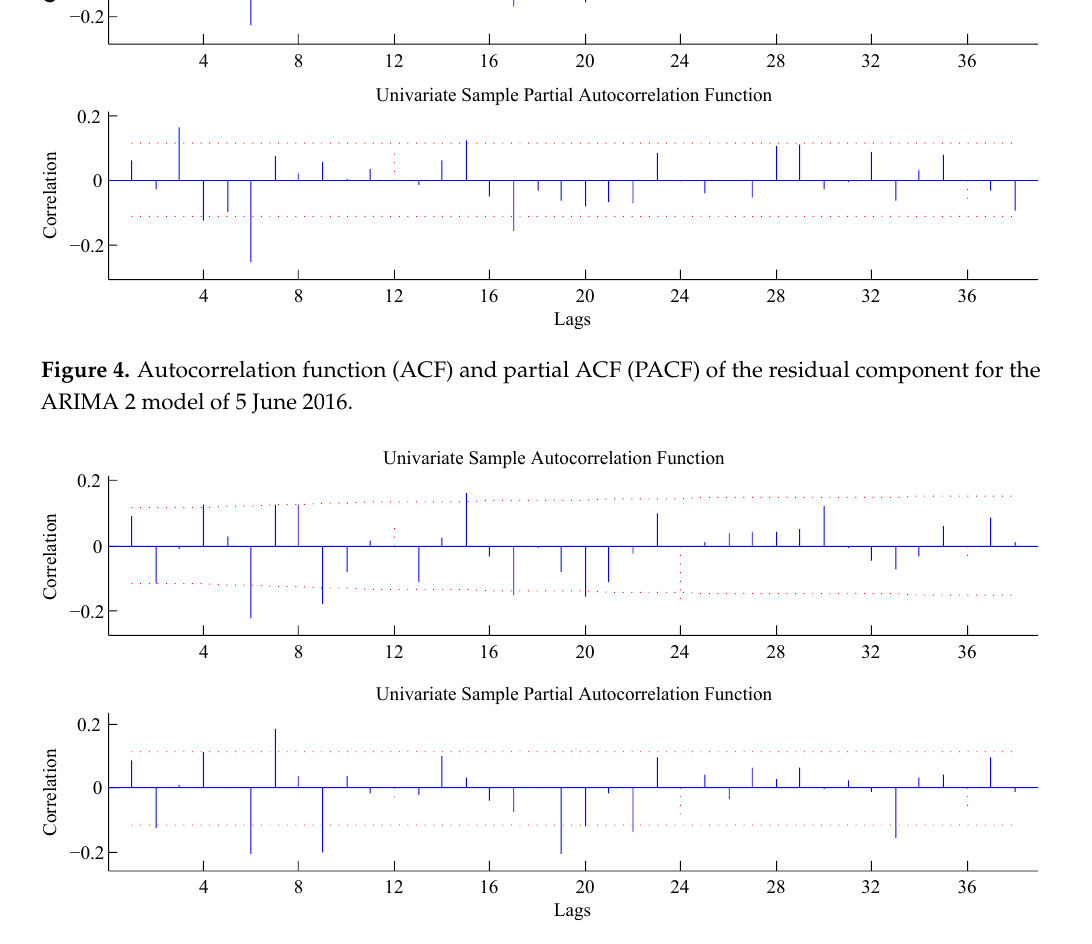
Figure 5. ACF and PACF of the residual component for the ARIMA 2 model of 6 June